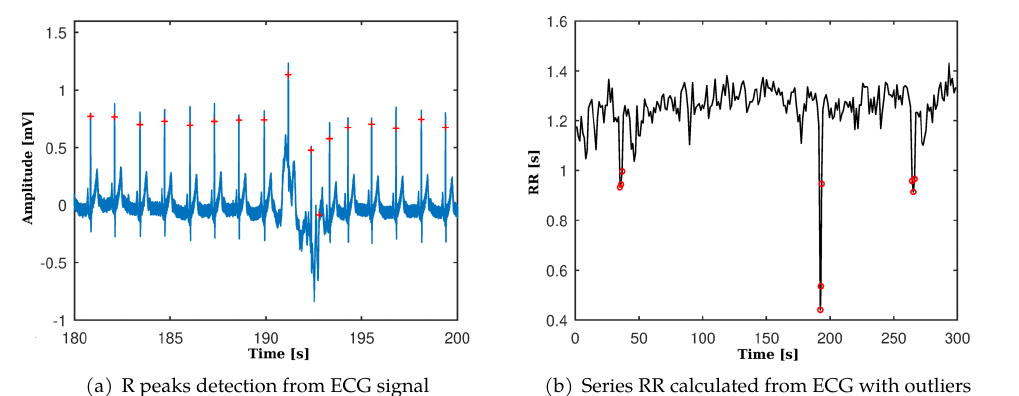
Figure 7: Processing of the ECG signal.